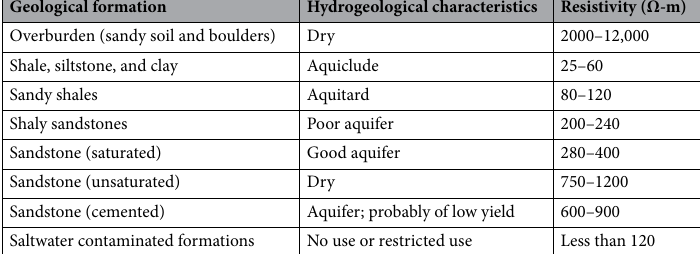
Table 7. Resistivity characteristic of different rock types (after Roy and Elliot 42 ).